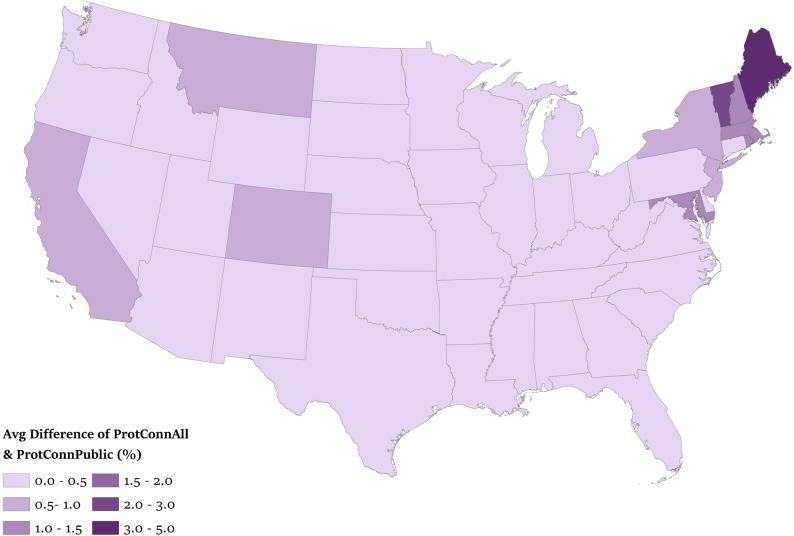
Difference between protected and connected patches (ProtConnAll) and only publicly protected patches connected (ProtConnPublic), averaged for seven dispersal distances in the contiguous United States.